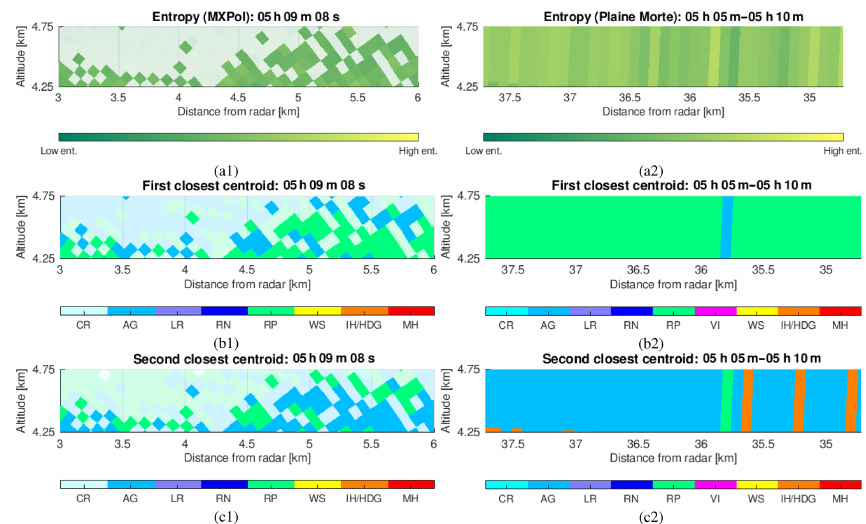
Figure 16. The example of (1) MXPol radar RHI and (2) Plaine Morte reconstructed RHI (from the dataset used in Sect. 3), with the accentuated volumes with entropy H > 0 . 4: (a) the entropy of the region of interest, (b) the first-closest centroid, (c) the second-closest centroid